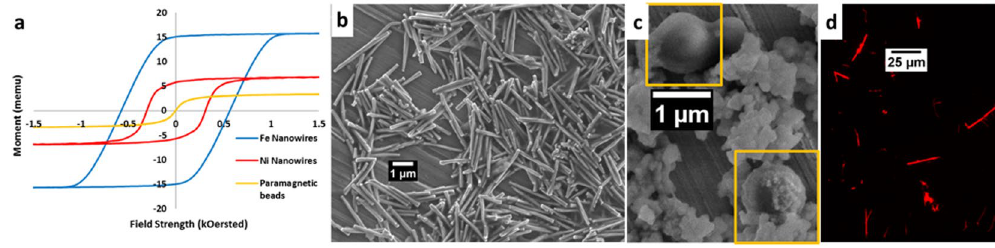
Figure 2. ( a ) Hysteresis curves for Fe nanowires (blue), Ni nanowires (red), and paramagnetic iron oxide beads (yellow). ( b ) SEM image of ferromagnetic Ni nanowires. ( c ) SEM image of paramagnetic beads; note the debris around the beads is likely a coating ( d ). Fluorescent microscopy images of Ni nanowires coated with fluorescently-tagged monomers, note these nanowires were not used for cell enrichment experiments.